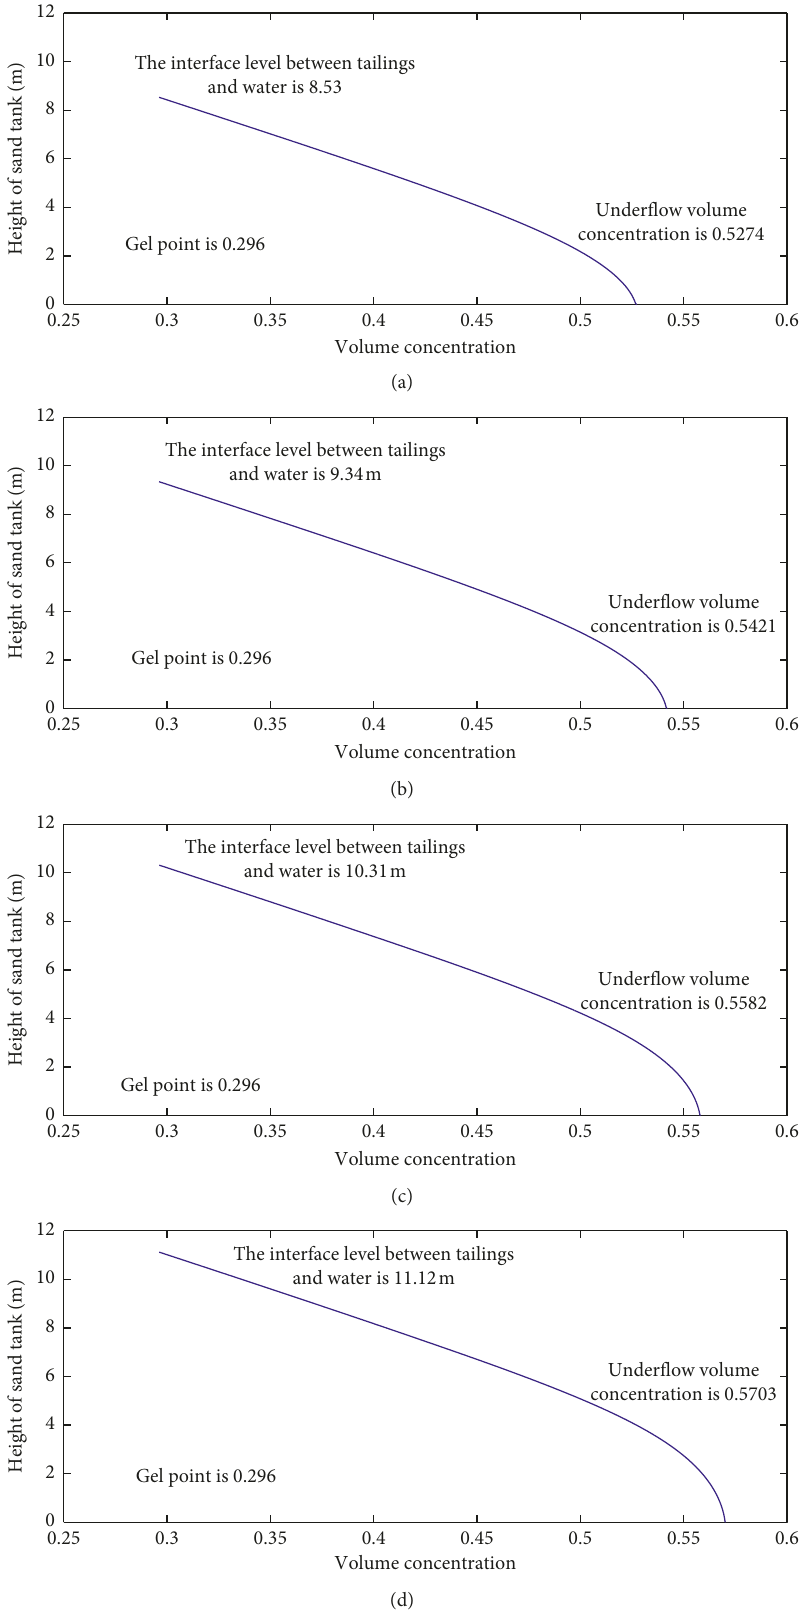
Figure 6: Curve of changing between volume concentration of the slurry and height of the tailing silo, with underflow volume con- centrations of (a) 0.5274, (b) 0.5421, (c) 0.5582, and (d)